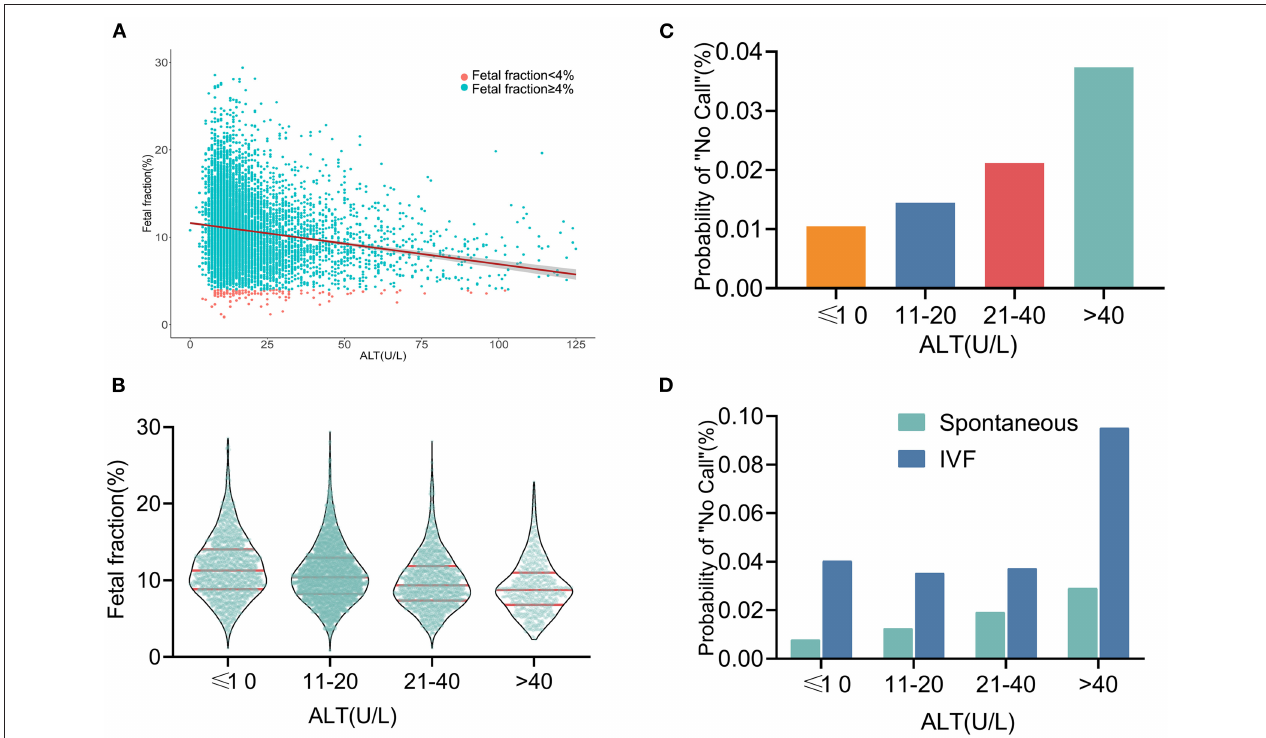
FIGURE 3 | Relationship between fetal fraction and ALT (A) Scatterplots of fetal fraction according to ALT levels with lines of best fit from linear regression. (B) Mean fetal fractions across ALT categories. (C) Test failure rate according to different groups of ALT. (D) In the same ALT categories, the probability of “no call” rates was significantly higher in IVF conceptions than in spontaneous conceptions. Similarly, in the spontaneously conceived pregnancies, the probability of “no call” rates were higher in the higher ALT group, especially in the group with an ALT level of > 40 U/L.